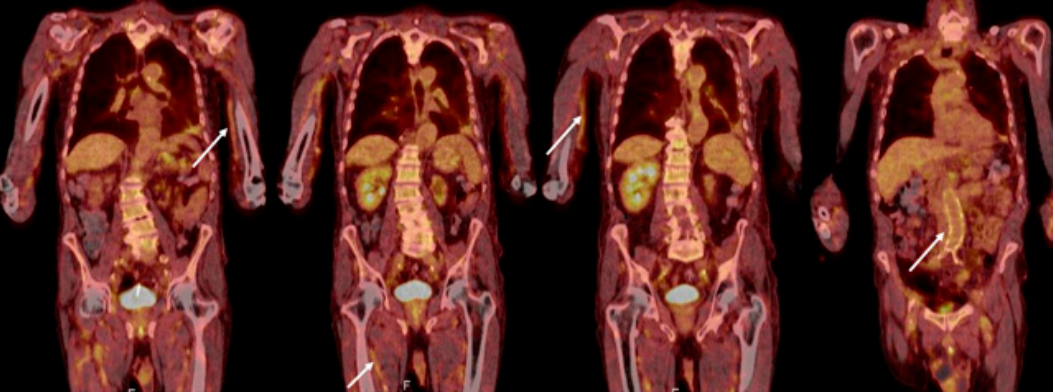
Figure 1. An 18F-fluorodeoxyglucose-positron emission (FDG-PET/CT) scan. Appearances were nonspecific with low grade increased tracer uptake in the arterial tree most prominent in both upper limbs and circumferentially around a non-dilated abdominal aorta, pelvis, and upper thighs (arrows). The causes of these appearances included a ‘blood pool effect’ related to timing of scan or diffuse low-grade vasculitis. Some focal activity in the partly consolidated left lower lobe of lung and related small left pleural effusion were reported as potential sites of infection.